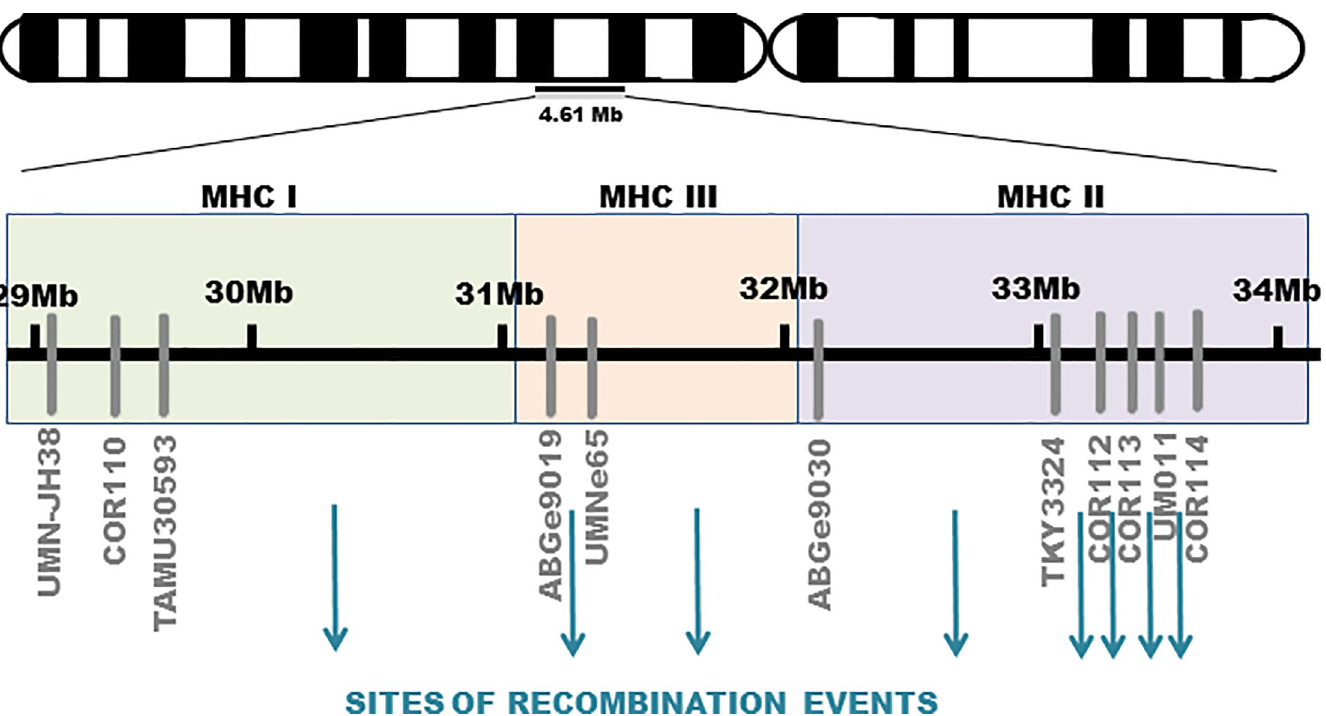
Fig 3. Map of intra-MHC microsatellites used in the study. MHC class I, MHC class II and MHC class III regions are located on the equine chromosome 20 and highlighted. Arrows indicate sites of recombination events within the equine MHC region in the studied population of horses.